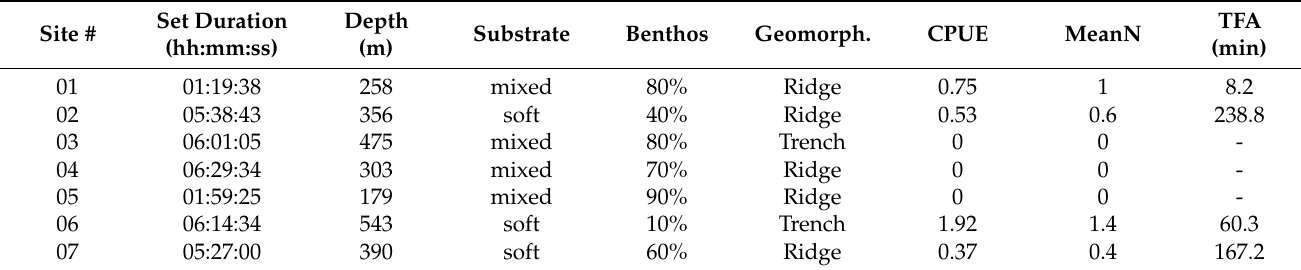
Table 2. Environmental variables considered to characterize the 7 sites of video sampling performed in 2018 at Silverfish Bay and relative measured abundance metrics. Geomorph = geomorphology; Mean N = Mean Number; TFA = Time of First